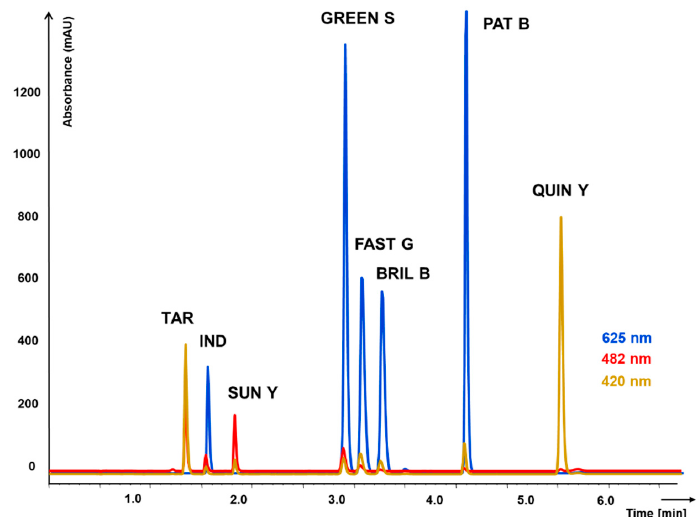
Figure 2. Chromatogram of 8 food synthetic dyes separation on fused-core column Ascentis Express ES-CN 100 × 4.6 mm, 5 µm. Gradient elution with mobile phase comprising of (A) acetonitrile and (B) water solution of 2% acetic acid (pH 7.0). Detection of individual dyes using the wavelength according to their maximal absorption.